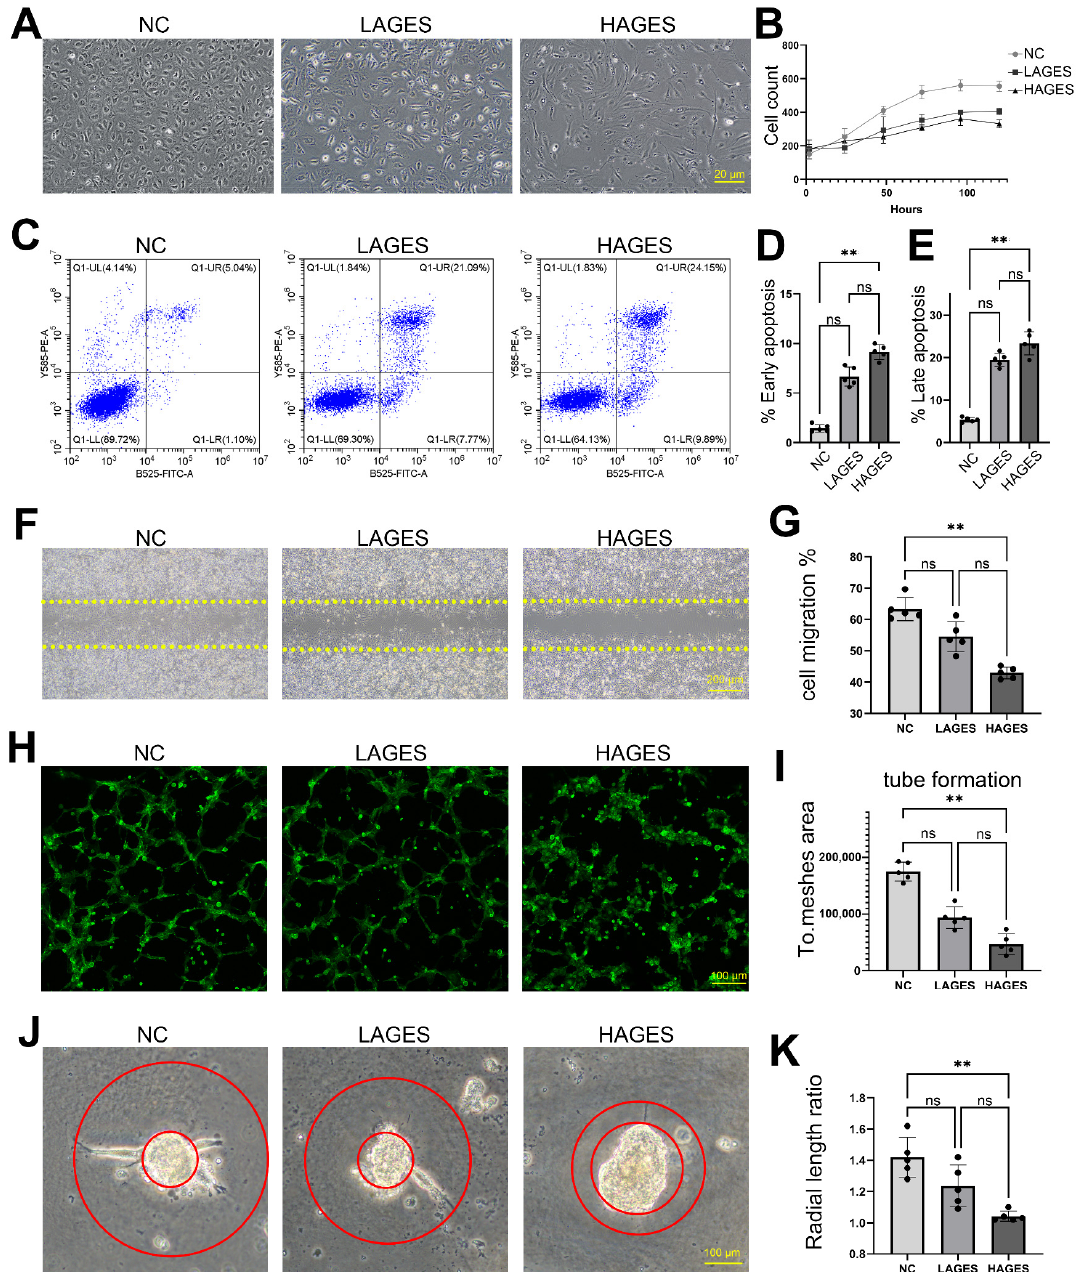
Figure 2. The effect of AGES treatment on CCECs. ( A ) Morphological changes of CCECs treated with different concentrations of AGES under light microscope in vitro. The scale bar represents 20 µm. ( B ) The cell count per 40× magnification region of CCECs treated with different concentrations of AGES for 5 days. ( C – E ) Flow cytometry demonstrates the different concentrations of AGES treat- ment on the early apoptosis ( D ) and late apoptosis ( D ) of CCECs. The existence of Annexin V ( X - axis) and the nuclear staining of PI ( Y -axis) by flow cytometry are shown. n = 5 independent repeats. ns, not significant; **, p < 0.01. ( F , G ) CCECs migration change after different concentrations of AGES treatment. n = 5 independent repeats. Data are shown as mean ± SD. ns, not significant; **, p < 0.01. ( H , I ) Co-staining of phalloidin (green) and Hoechst33342 (blue), showing typical changes of CCECs tube formation after different concentrations of AGES treatment. The total mesh area score is used to represent the level of tube formation in each group. n = 5 independent repeats. Data are shown as mean ± SD. ns, not significant; **, p < 0.01. ( J , K ) The radial length of CCEC mass vascular bud change after different concentrations of AGES treatment. n = 5 independent repeats. Data are shown as mean ± SD. ns, not significant; **, p < 0.01. NC: negative control (0 µg/mL AGES); LAGES: low level (20 µg/mL) of advanced glycation end products-treated group; HAGES: high level (100 µg/mL) of advanced glycation end products-treated group.